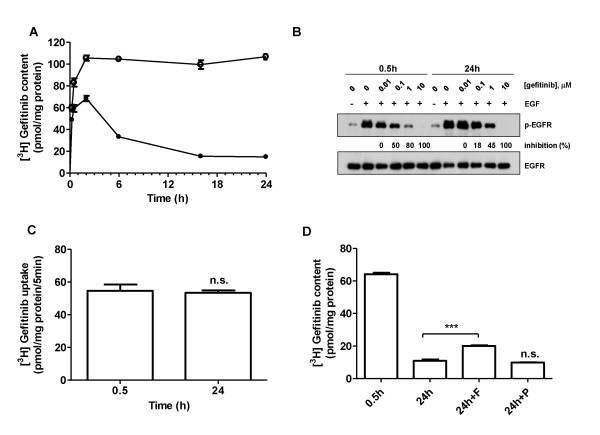
Intracellular content of gefitinib in NSCLC cell lines and its effect on EGFR autophosphorylation. A) Time course of 0.1 μM [3H]gefitinib accumulation in H322 (●) and H1299 (○) cell lines. Each point represents the mean ± SD of four independent determinations. B) H322 cells were incubated for 0.5 h and 24 h with the indicated extracellular concentrations of gefitinib before stimulation with 0.1 μg/ml EGF for 5 min. Western blot analysis was performed by using monoclonal antibodies directed to p-EGFR(p-Tyr1068) and to EGFR. The immunoreactive spots were quantified by densitometric analysis, ratios of phosphotyrosine/total EGFR were calculated and values are expressed as percentage of inhibition versus control. The experiment, repeated three times, yielded similar results. C) H322 cells were incubated with 0.1 μM gefitinib for 0.5 h or 24 h and then the initial rate (5 min) of 0.1 μM [3H]gefitinib uptake was measured. Each bar represents the mean ± SD of four independent determinations. D) H322 cells were exposed to 0.1 μM [3H]gefitinib for 0.5 h and 24 h, in the absence or in the presence of 10 μM Fumetrimorgin C (F) or PSC833 (P) and then intracellular gefitinib content was determined. Values given are the means (± SD) of three independent determinations (***P < 0.001).